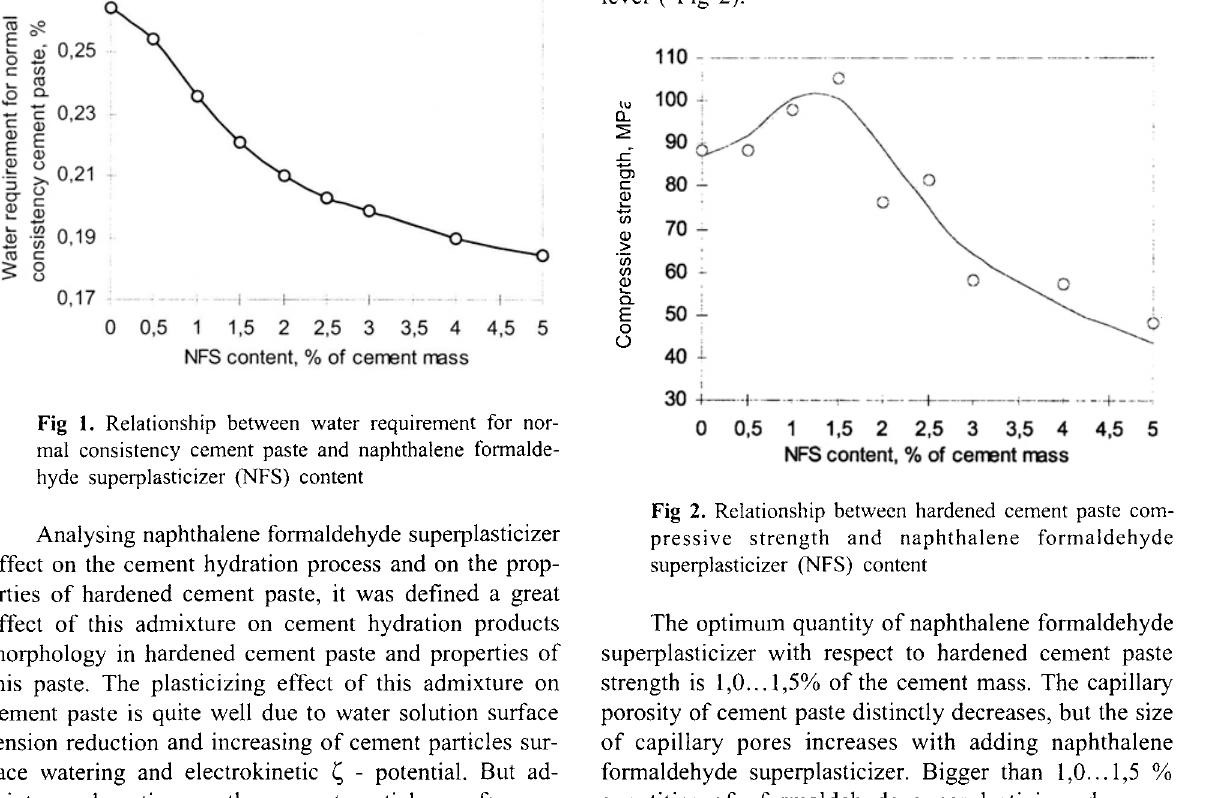
Due to the complex infuence of these two factors the compressive and bending strength of hardened ce ment paste increases only with increasing of naphthalene formaldehyde superplasticizer quantity up to a certain level ( Fig 2).